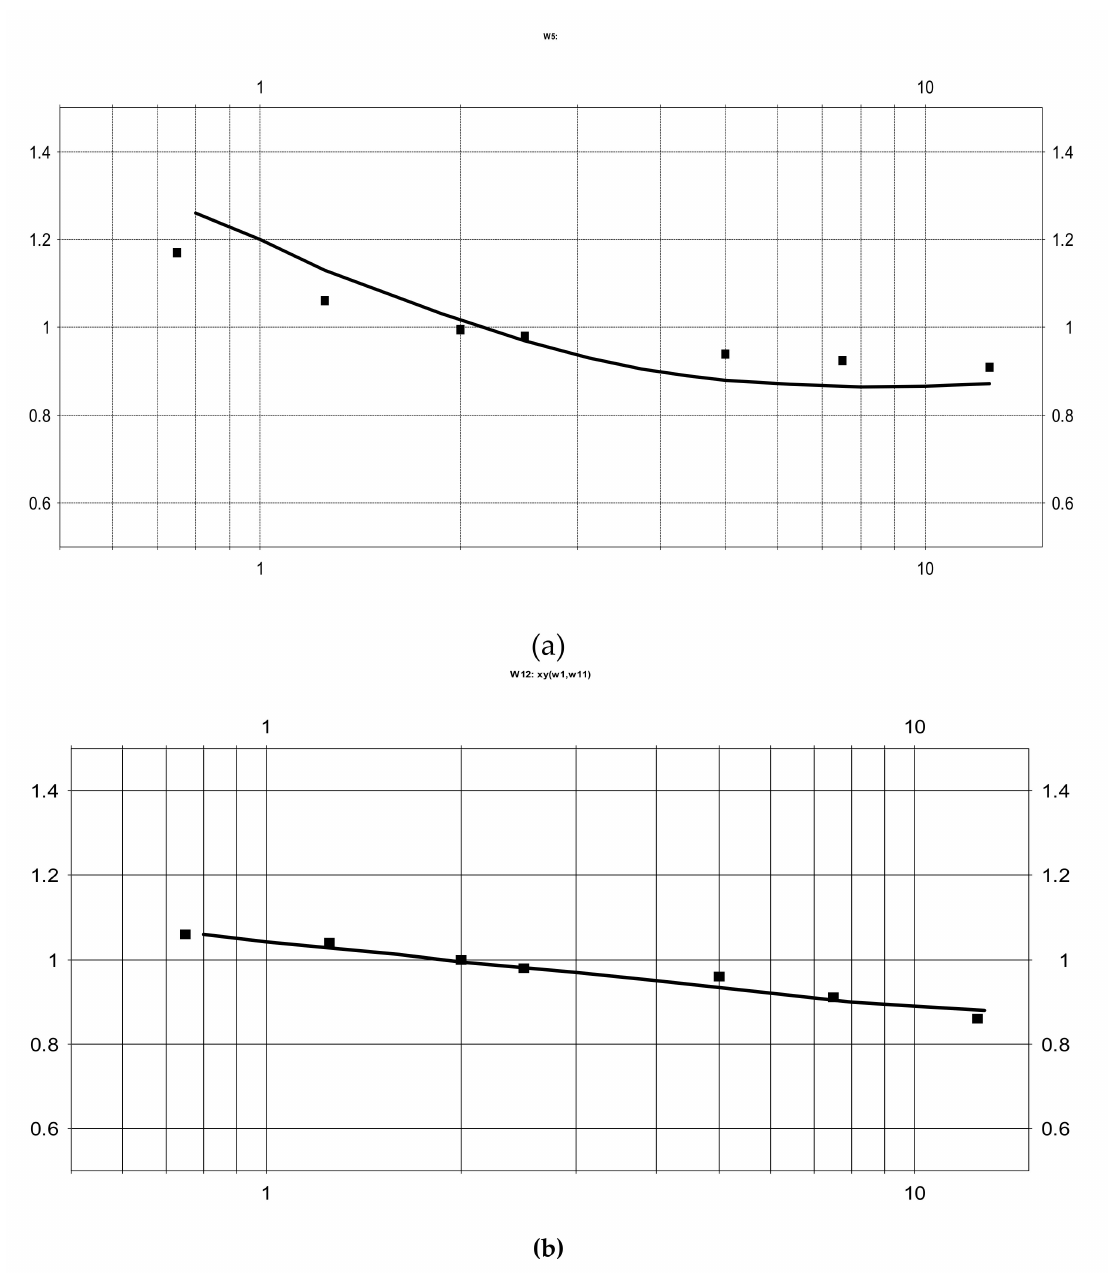
Figure 11. Relative frequency response for the cells with di ff erent distance between cathodes vs. dimensionless frequency. ( a )—Sample 1; ( b )—Sample